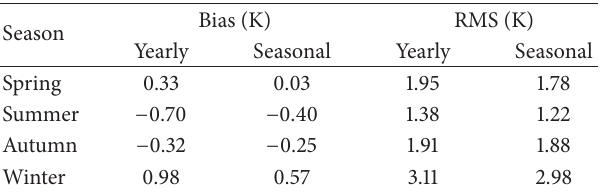
Table 5: Comparison of the biases and RMSs of the seasonal and yearly two-factor RTM-derived 𝑇 𝑚 in four